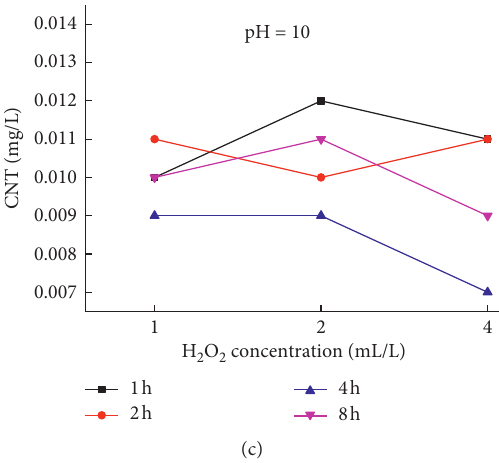
Figure 3: Cyanide as a function of H